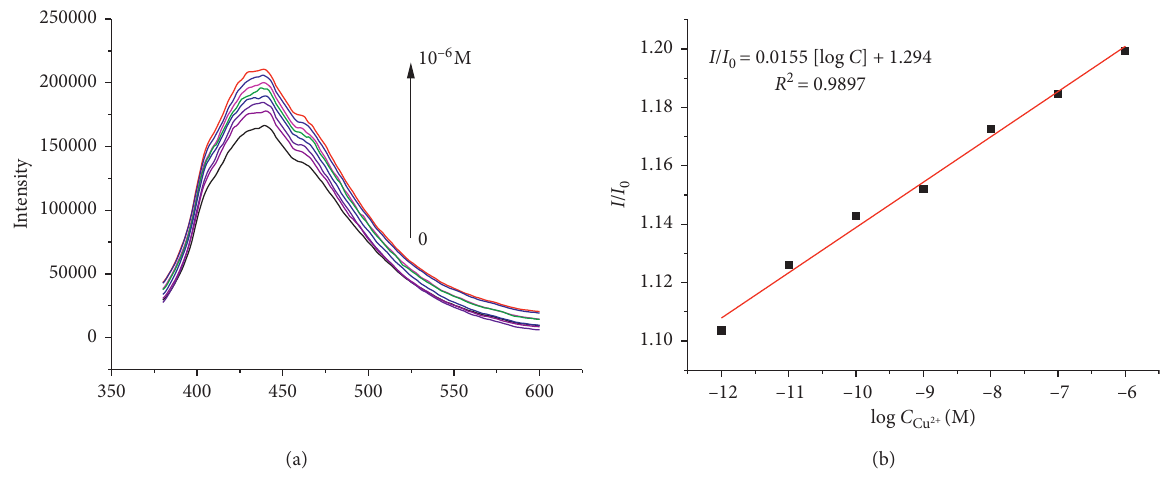
Figure 5: (a) Fluorescence response of the Ag NCs upon addition of different concentrations of Cu 2+ from bottom to top: 0.1 × 10 − 12 M, 1 × 10 − 11 M, 1 × 10 − 10 M, 1 × 10 − 9 M, 1 × 10 − 8 M, 1 × 10 − 7 M, and 1 × 10 − 6 M. (b) The linear calibration ranges of the fluorescence intensity ratio to Cu 2+